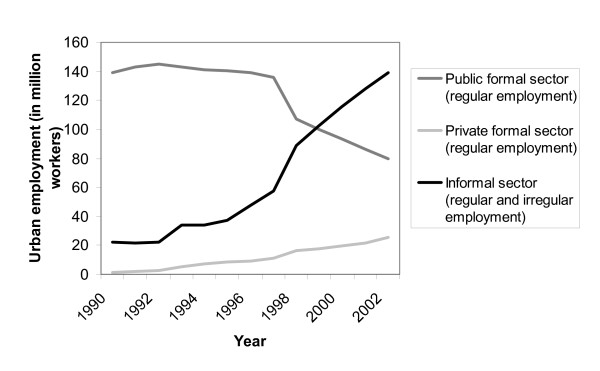
Structure of urban employment in China, 1990–2002.